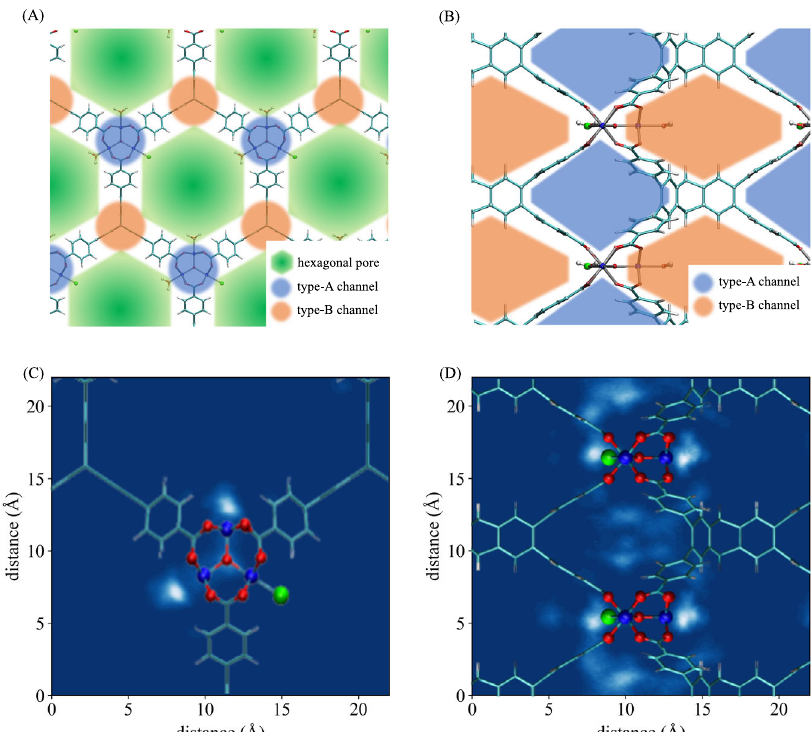
Fig. 2 NU-1500-Cr structure and water density distribution. A Structure of NU-1500-Cr viewed along the hexagonal pore direction. The hexagonal pores are shown in green, while type-A and type-B channels are shown in blue and orange, respectively. B Structure of NU-1500-Cr viewed along a direction perpendicular to the hexagonal pore direction. The hexagonal pores are not displayed for the clarity, while type-A and type-B channels are shown in blue and orange, respectively, as in ( A ). Two-dimensional water density distribution calculated along ( C ) and perpendicular ( D ) to the hexagonal pore direction at 14.7% RH. Lighter regions correspond to higher water density. Color scheme: C = cyan, H = white, O = red, Cr = blue, Cl = green.